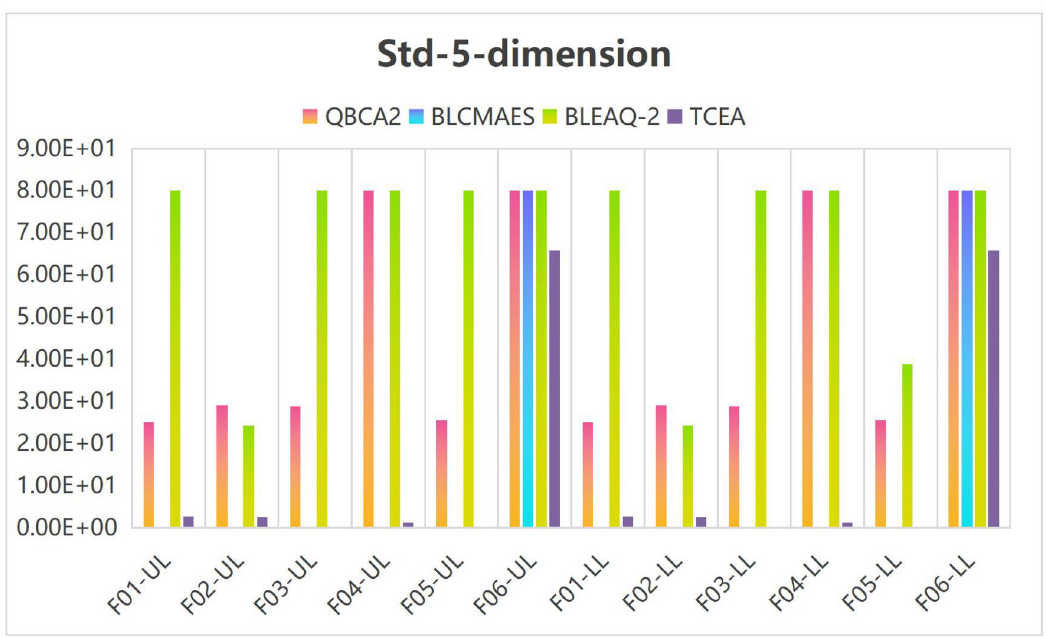
Fig 3. Histogram of the Std values on 5-dimensional problems.